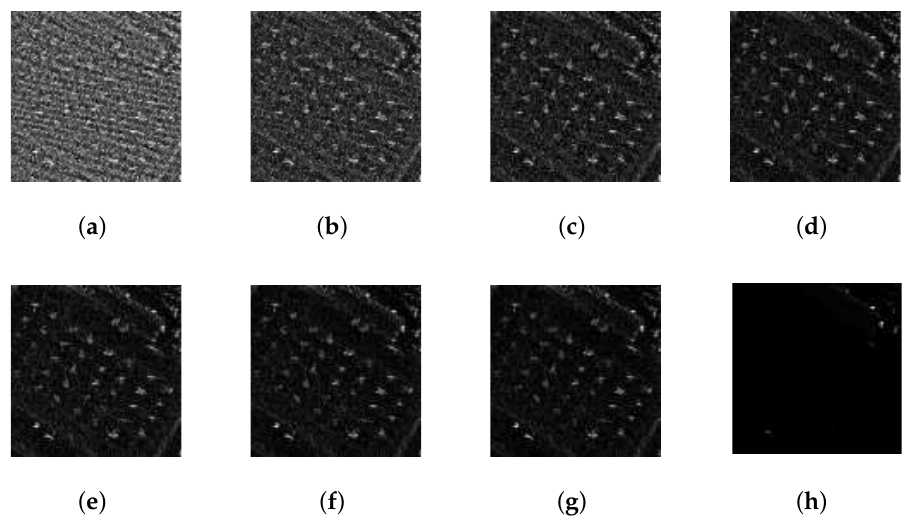
Figure 8. Detection abundance fractional maps of AVIRIS by recursive local summation RXD (R-LS-RXD) with different sliding window size: ( a ) ω =5; ( b ) ω =7; ( c ) ω =9; ( d ) ω =11; ( e ) ω =13; ( f ) ω =15; ( g ) ω =17; ( h ) global.